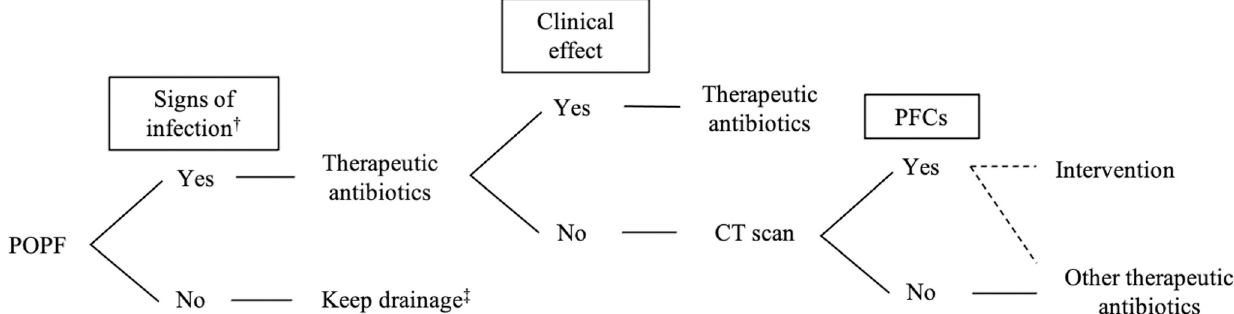
Fig 1. Our basic therapeutic strategies for postoperative pancreatic fistula after distal pancreatectomy. †High-grade temperature � 38.5˚C and/or high inflammatory responses. ‡Intraoperative drain is kept and exchanged once a week until the volume of discharge decreases. CT: computer tomography, DP: distal pancreatectomy, POPF: postoperative pancreatic fistula, PFCs: peripancreatic fluid collections.